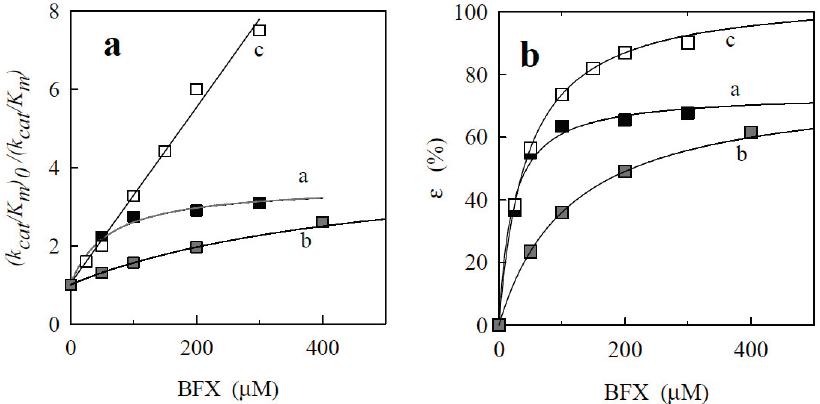
Figure 7. ( a ) The dependence of (k cat /K m ) 0 /(k cat /K m ) ratio on concentrations of BFXs (k cat /K m0 and k cat /K m denote the apparent second rate constants of NADPH oxidation in the absence and presence of BFXs as inhibitors, respectively): benzofuroxan (curve a), 5,6-methylendioxybenzofuroxan (curve b), and benzotrifuroxan (curve c); ( b ) The inhibition degree ( ε ) of NQO1 on varied concentrations of